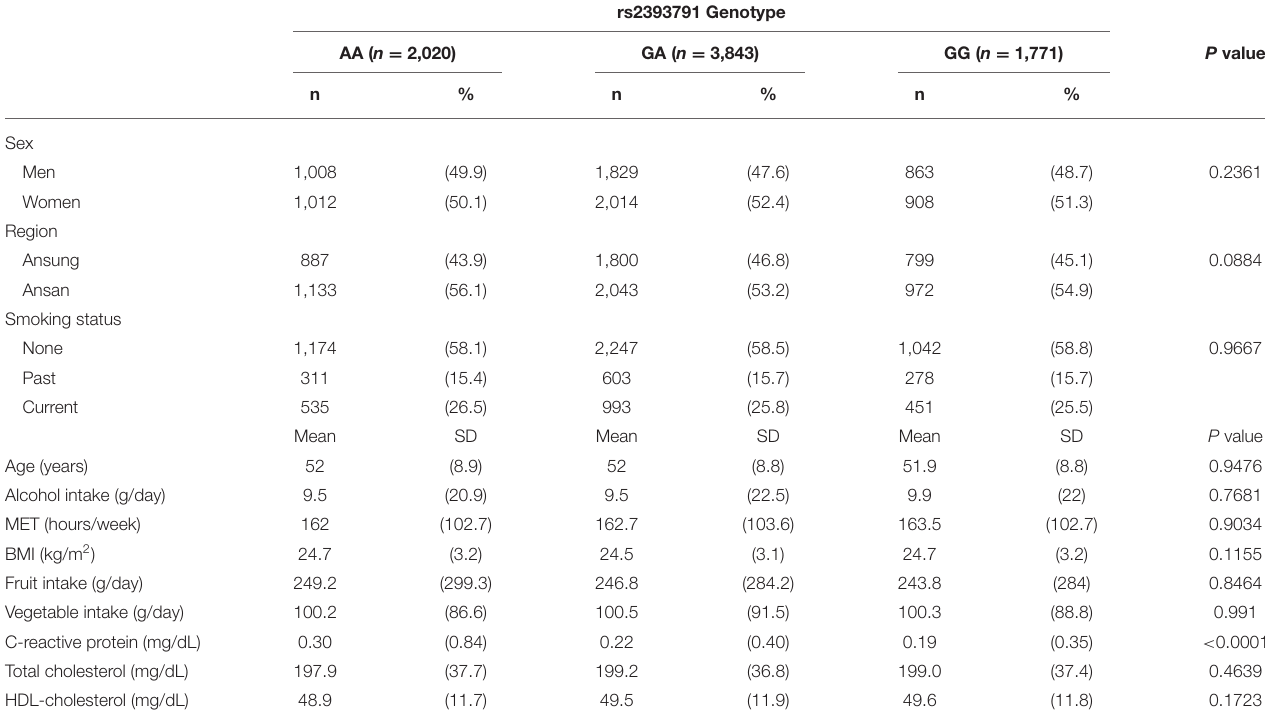
TABLE 2 | Characteristics of study participants by HNF1A rs2393791 genotype.